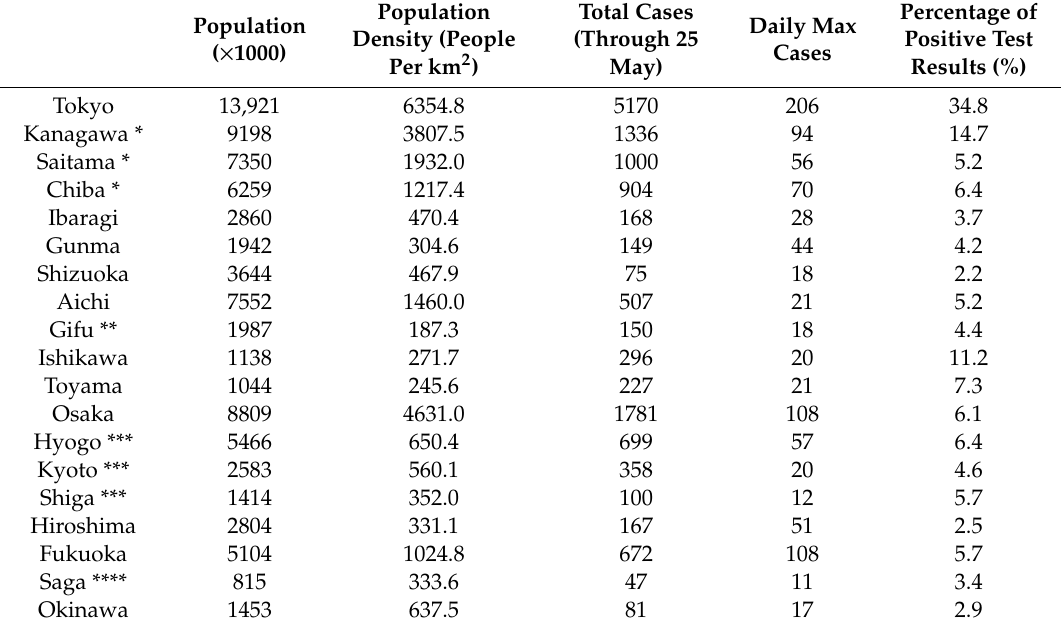
Table 1. Population, area, and population density data of 19 prefectures where daily maximum cases of COVID-19 exceeded 10. Total cases of COVID-19 and mean percentages of the positive test cases are also